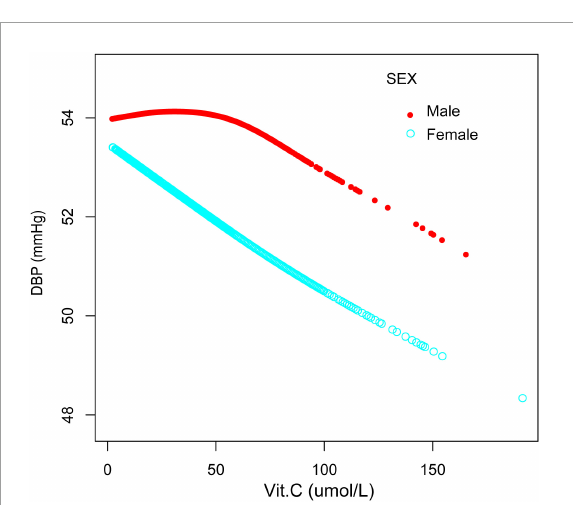
FIGURE7 The association between vitamin C and DBP, stratified by age. Sex, race/ethnicity, marital status, education level, ratio of family income to poverty, BMI, smoking states, pulse, ALT, ALP, AST, BUN, globulin, Cr, TG, TC, LDL, HDL, glycohemoglobin, TP, FBG, γ GT, and sUA were